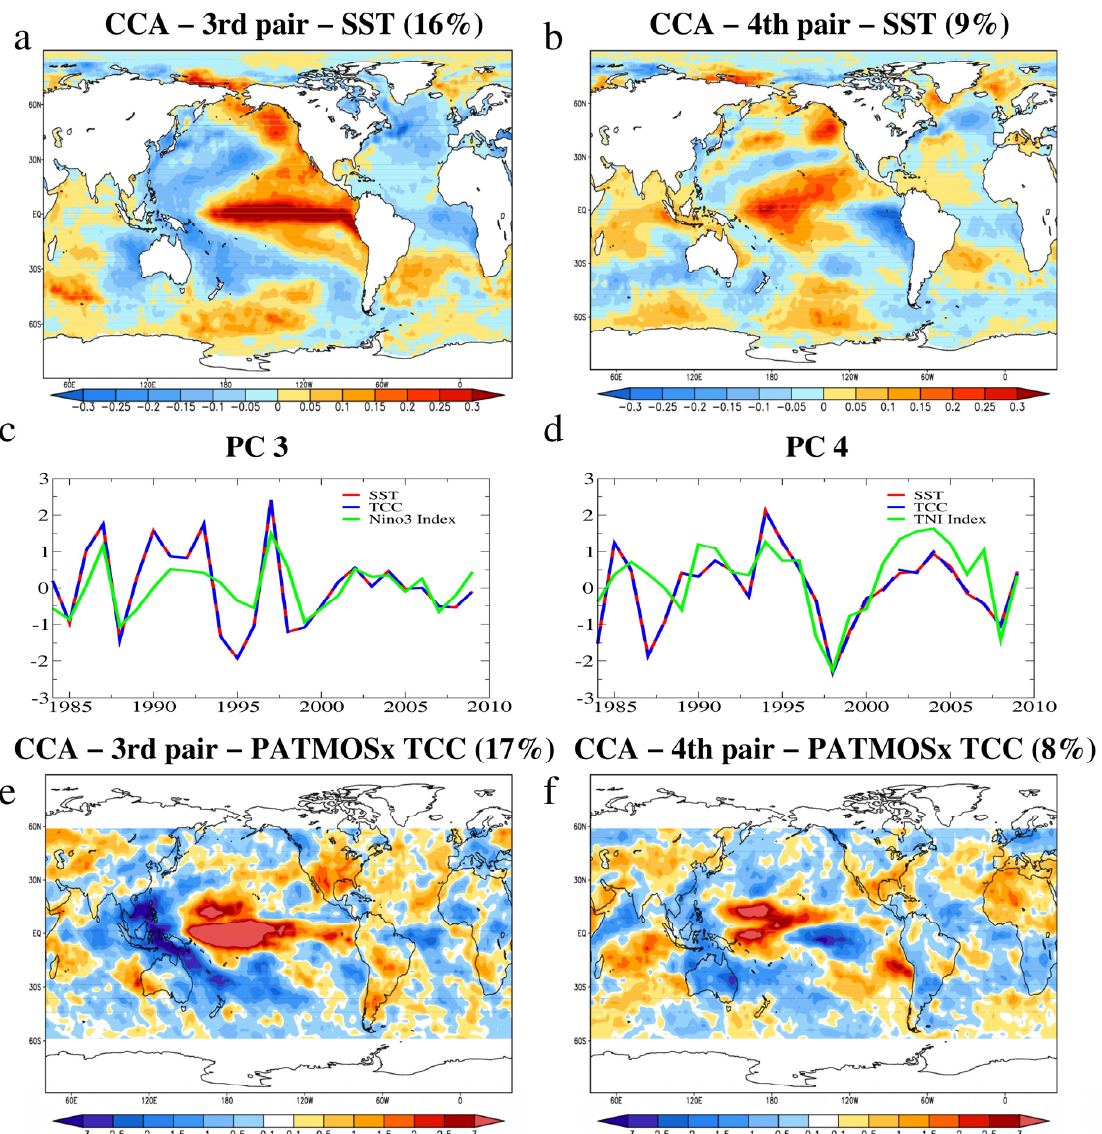
Figure 3. The EP ENSO and the CP ENSO footprints on global SST–TCC coupled fields, identified through CCA using PATMOS-x TCC data on the 1984–2009 period. The left column shows the third most coupled SST (°C)—TCC (%) pair, the SST pattern ( a ), explaining 16% of variance, the TCC structure ( e ), explaining 17% of variance and the time series ( c ) associated with TCC (blue line) and SST (red line). The correlation with the Niño3 index (green line) is 0.79. The right column shows the fourth most coupled SST (°C)—TCC (%) pair, the TCC pattern ( b ), explaining 9% of variance, the SST structure ( f ), explaining 8% of variance and the time series ( d ) associated with TCC (blue line) and SST (red line). The correlation with the TNI (green line) is 0.73.